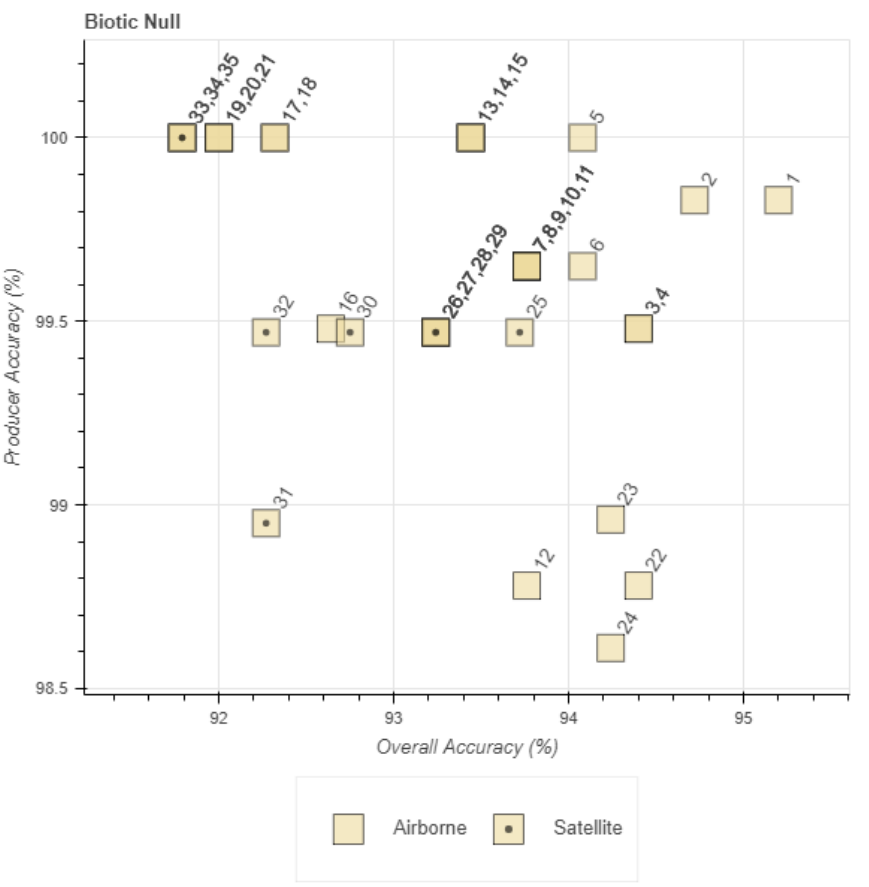
Figure 17. Tier 1 plot of biotic null classification performance, comparing percent overall accuracy and percent producer accuracy for airborne and satellite data combinations. Number labels refer to unique classification input data combinations identified in the Index field in Table A2, Appendix A.